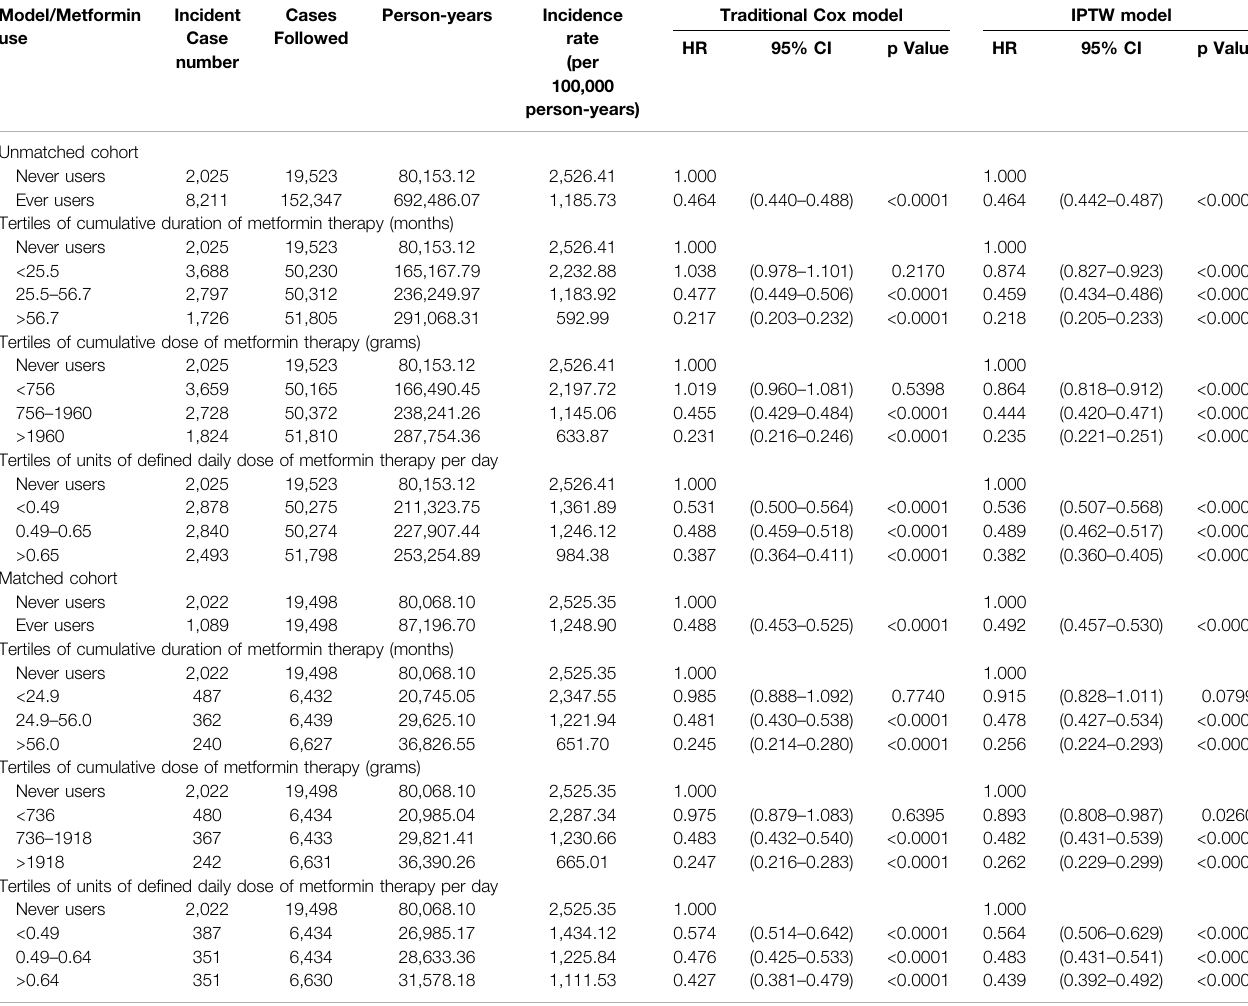
TABLE 2 | Incidence rates of hemorrhoid and hazard ratios by metformin exposure. Model/Metformin